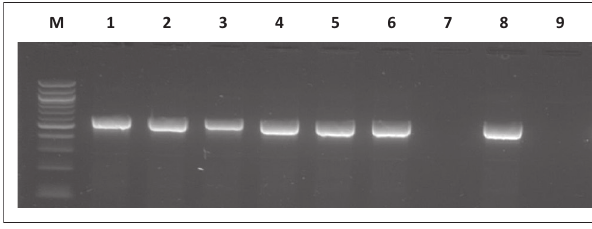
FIGURE 11: Detection of the 350 bp sul 1 gene amplicon from seven representative Salmonella isolates by agarose gel electrophoresis.